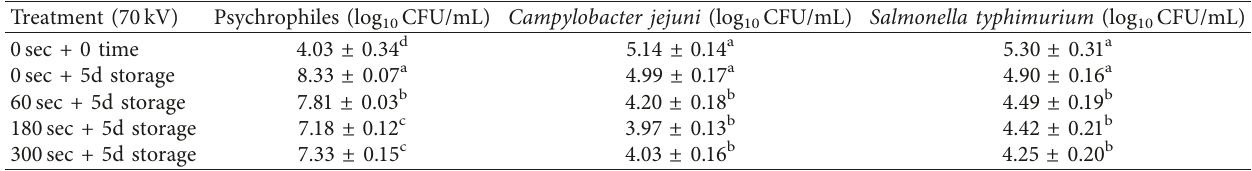
Table 2: Effect of cold plasma treatment time on populations (log (mean ±